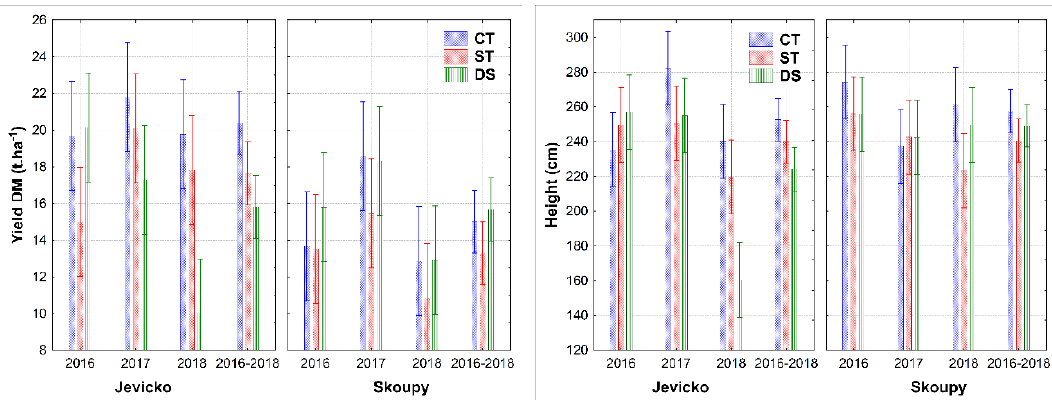
Figure 2. The dry mass yield of silage maize and the average height of maize plants in period 2016– 2018.